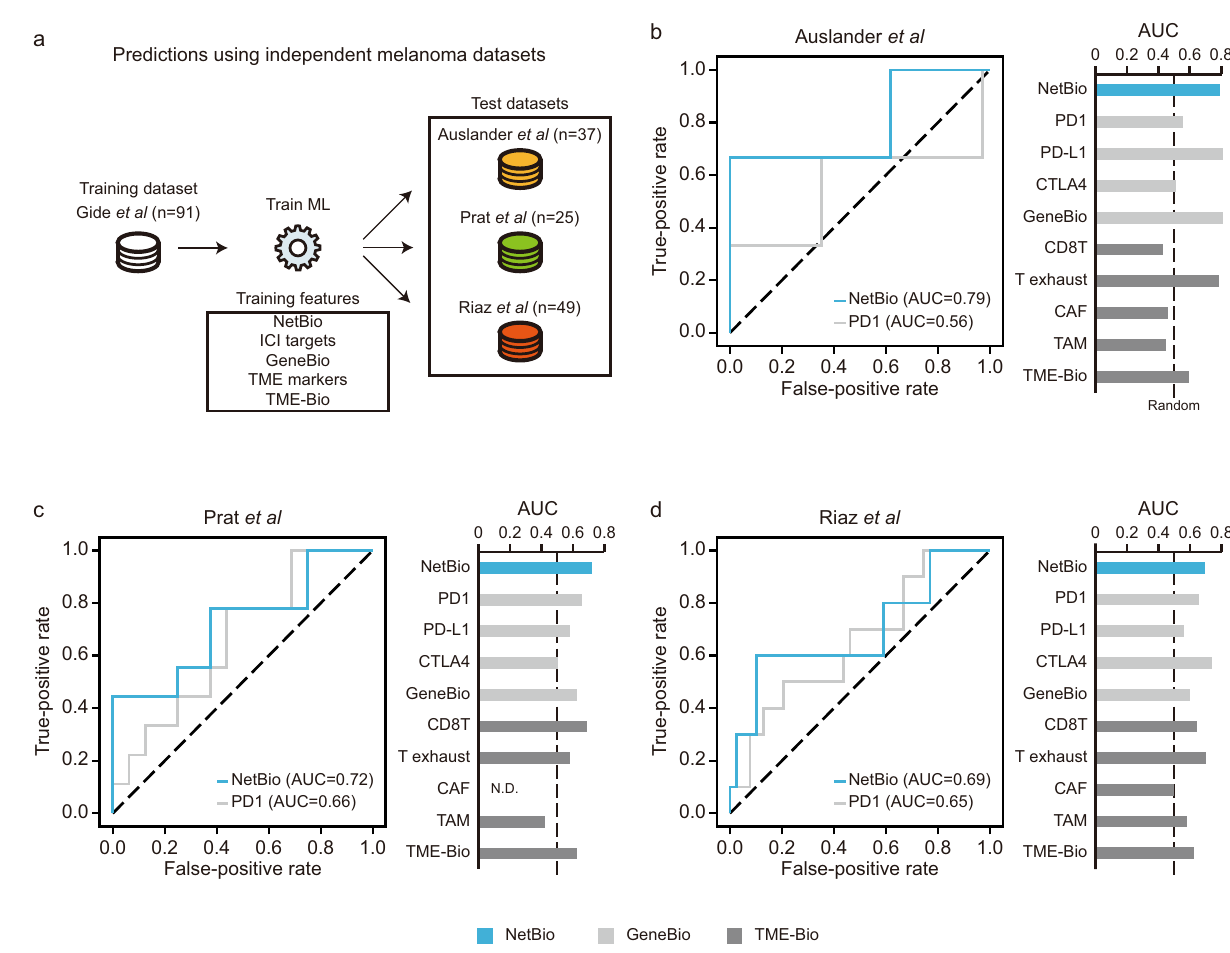
Fig. 3 Predictive performance in three independent melanoma datasets. a Overall scheme of immunotherapy-response predictions in three independent datasets. The datasets and transcriptomic features used to train and test the machine-learning models and the number of samples for each dataset are displayed. b – d The area under the receiver operating characteristic curve (AUC) for the ( b ) Auslander, ( c ) Prat, and ( d ) Riaz datasets is shown. The random expectation, equaling an AUC of 0.5, is displayed as dotted lines. Expression pro fi les of cancer-associated fi broblast (CAF) marker genes were not available in the Prat dataset. N.D. not detected. Source data are provided as a Source Data fi